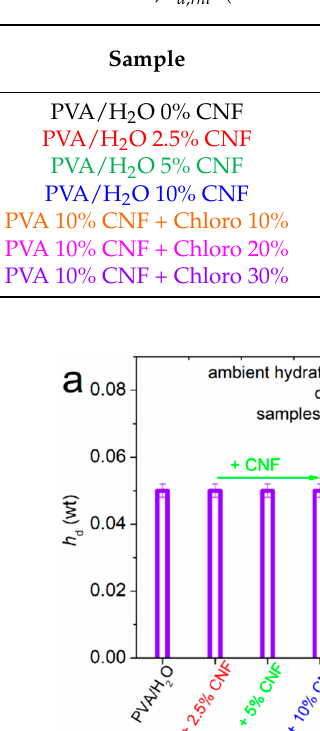
Table 1. Hydrations on dry sample basis, for the samples as received at ambient humidity, h d,amb , and subjected to various relative humidities, h d,rhi . ( i = 2–98%).